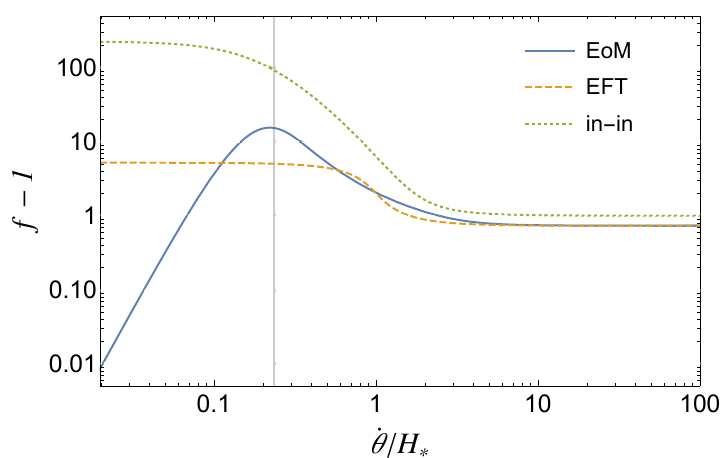
Figure 4 . The ratio f = P (cid:18) =P (cid:3) of the power spectrum with respect to the parameter _ (cid:18) 0 =H (cid:3) in the (cid:18) H -rescaling scheme. The vertical line describes the threshold value for the heavy Higgs condition.